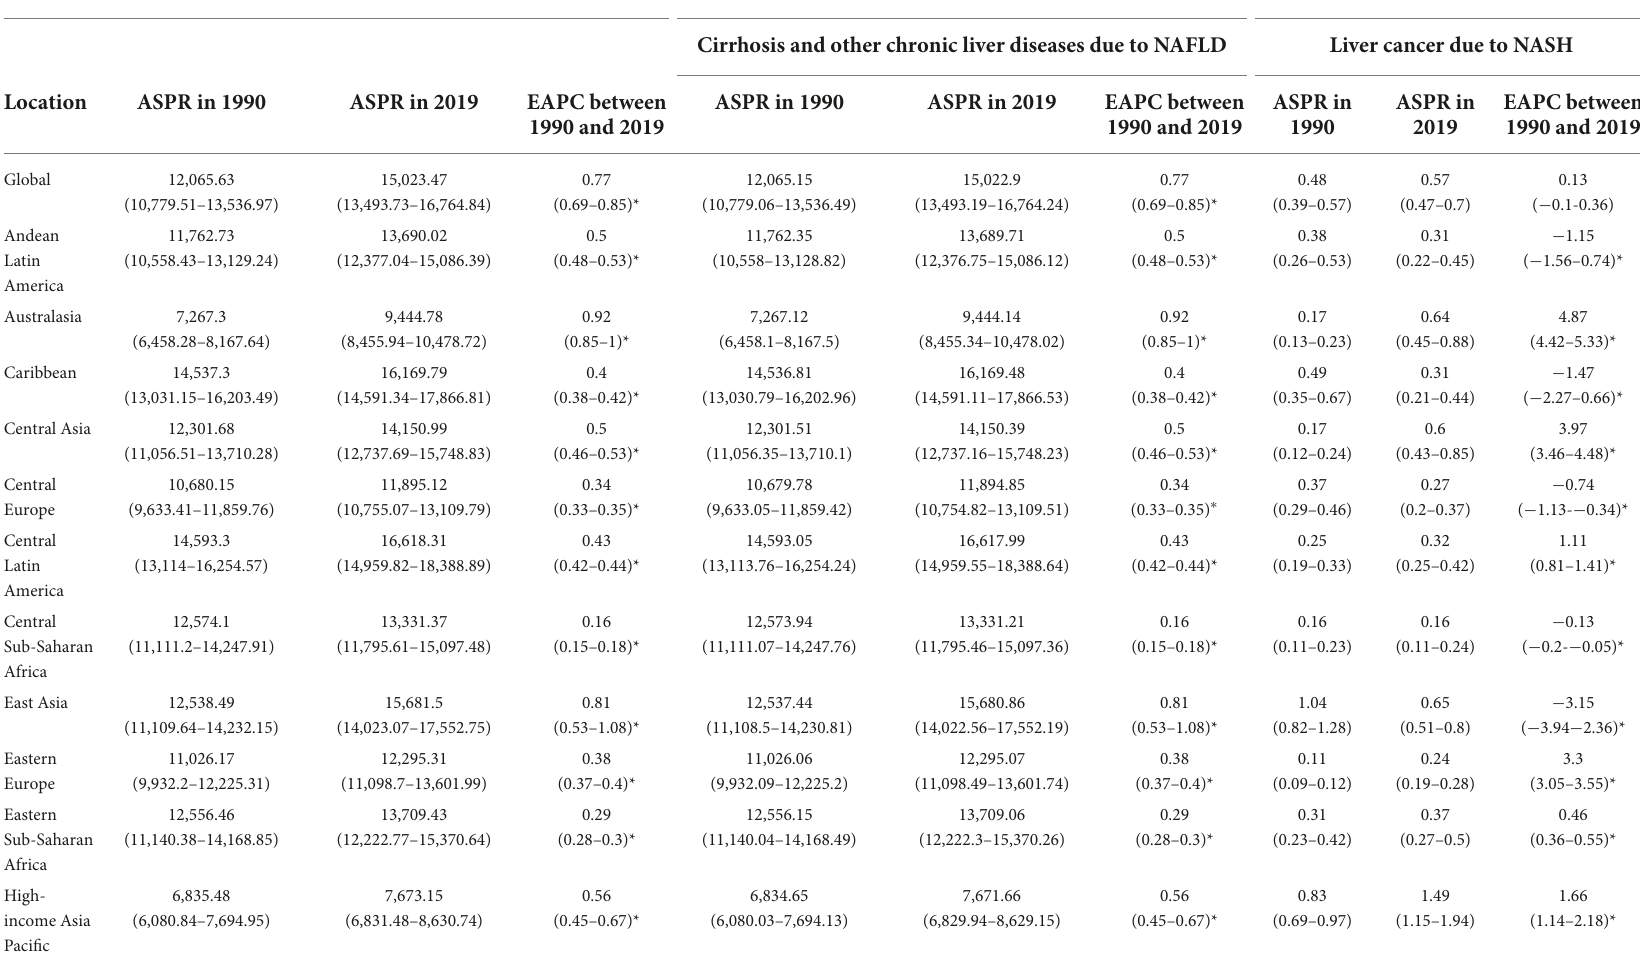
TABLE 1 Age-standardized prevalence rate (ASPR) for NAFLD, cirrhosis, and liver cancer in 1990 and 2019 for both sexes, and estimated annual percentage changes (EAPCs) by Global Burden of Disease (GBD) region.